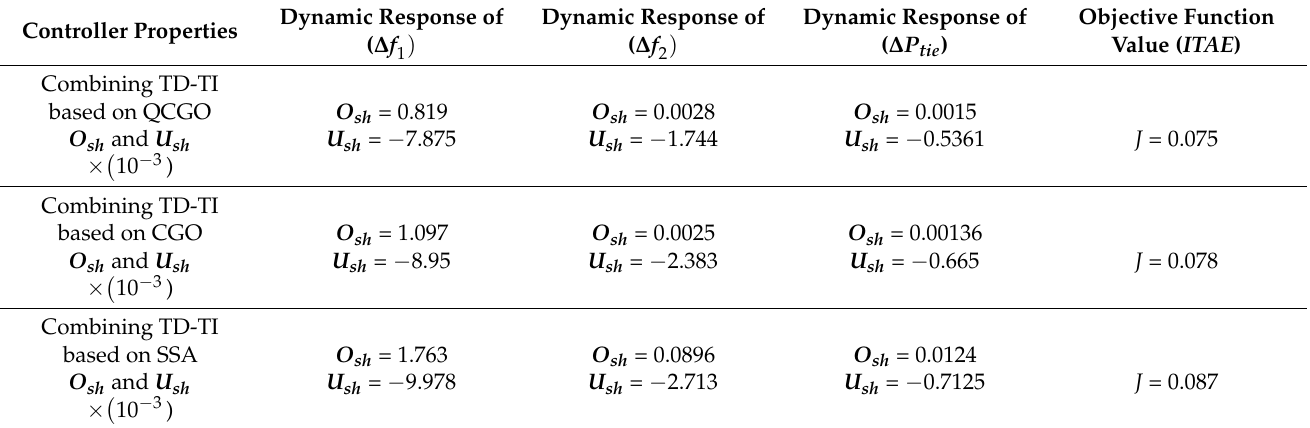
Table 12. The transient response specifications of the presented system for case A.1.3.